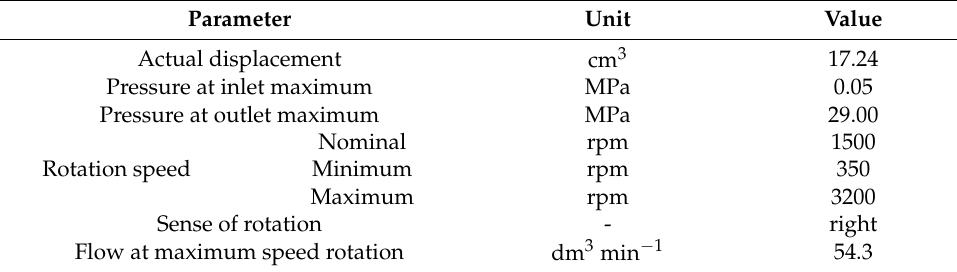
Table 3. Hydraulic gear motor QM2